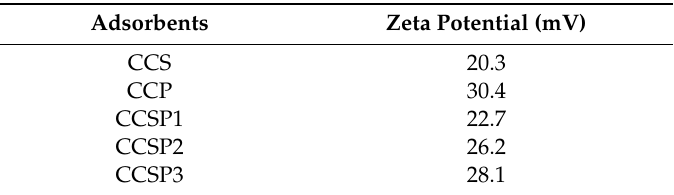
Table 2. The zeta potential of the prepared